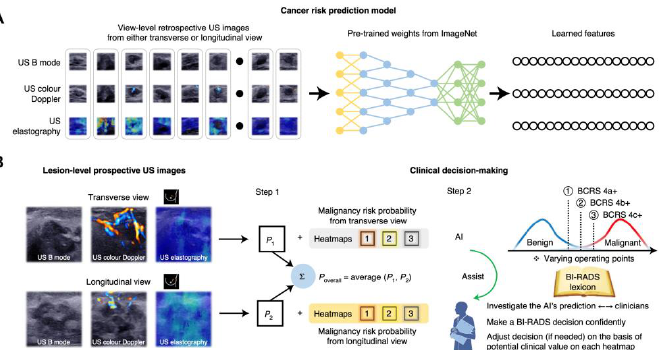
Figure 2. A DL-based system for BC risk prediction [93]. ( A ) The construction of DL model. The DL model was developed using multimodal US images (including US B-mode, US color Doppler, and US elastography), trained through multiple layers from ImageNet, and subsequently acquiring fea- tures. ( B ) Cancer prediction via DL model and clinical decision-making. The DL system inputs mul- timodal US images and outputs an overall probability of malignancy. According to the BIRADS lexicon, three different breast cancer risk scores (BCRS 4a+, BCRS 4b+, BCRS 4c+,) were proposed in the prediction system to assist radiologists to make clinical